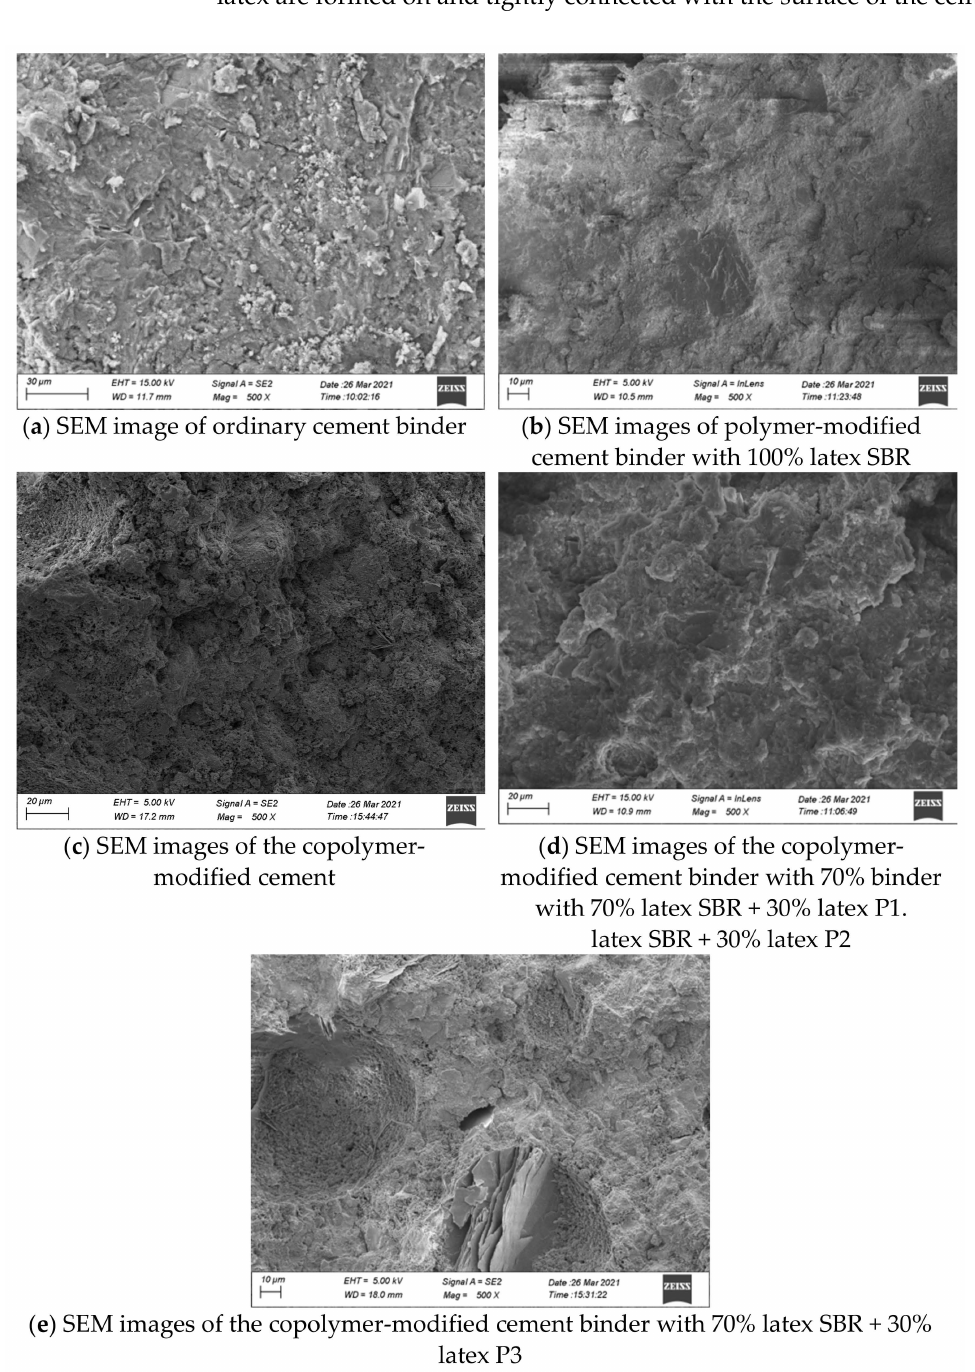
Figure 7. SEM images of the ordinary cement and polymer-modified cement